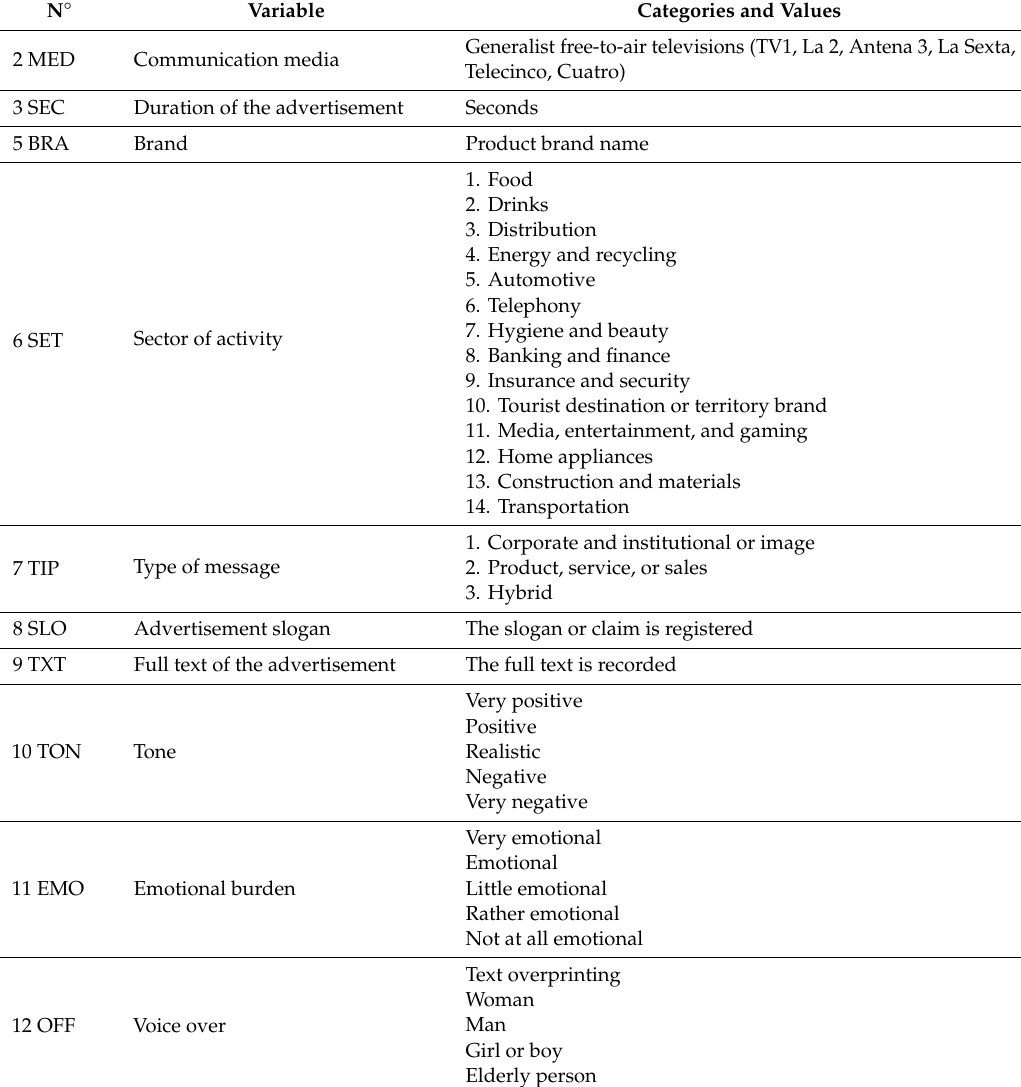
Table 2. Analysis content